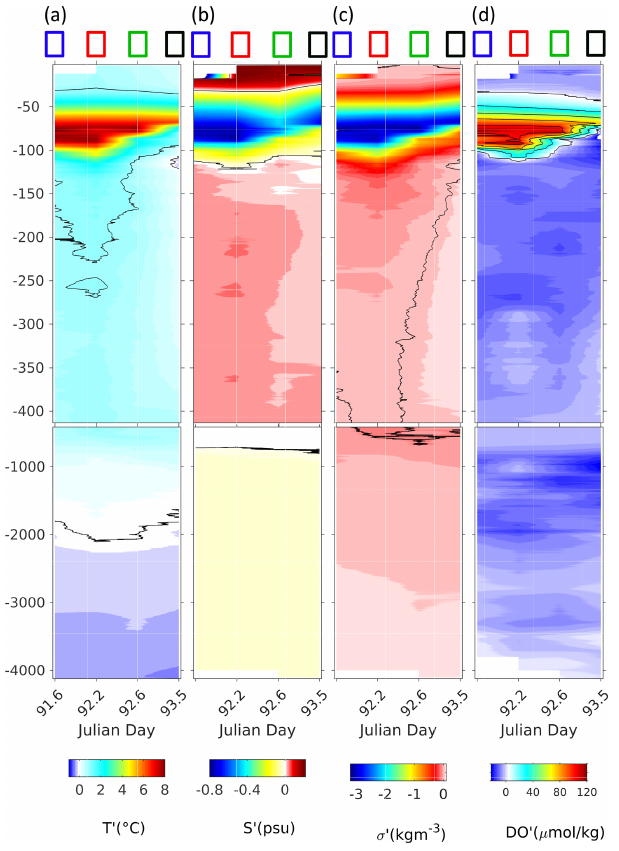
Figure 7. Vertical sections of (a) temperature anomaly, (b) salinity anomaly, (c) density anomaly, and (d) dissolved oxygen anomaly along the zonal transect of A2–A3 with respect to the WOA18 data. The color boxes at the top of each subplot (blue, red, green, and black) indicate the respective CTD stations of 08, 09, 10, and 11.